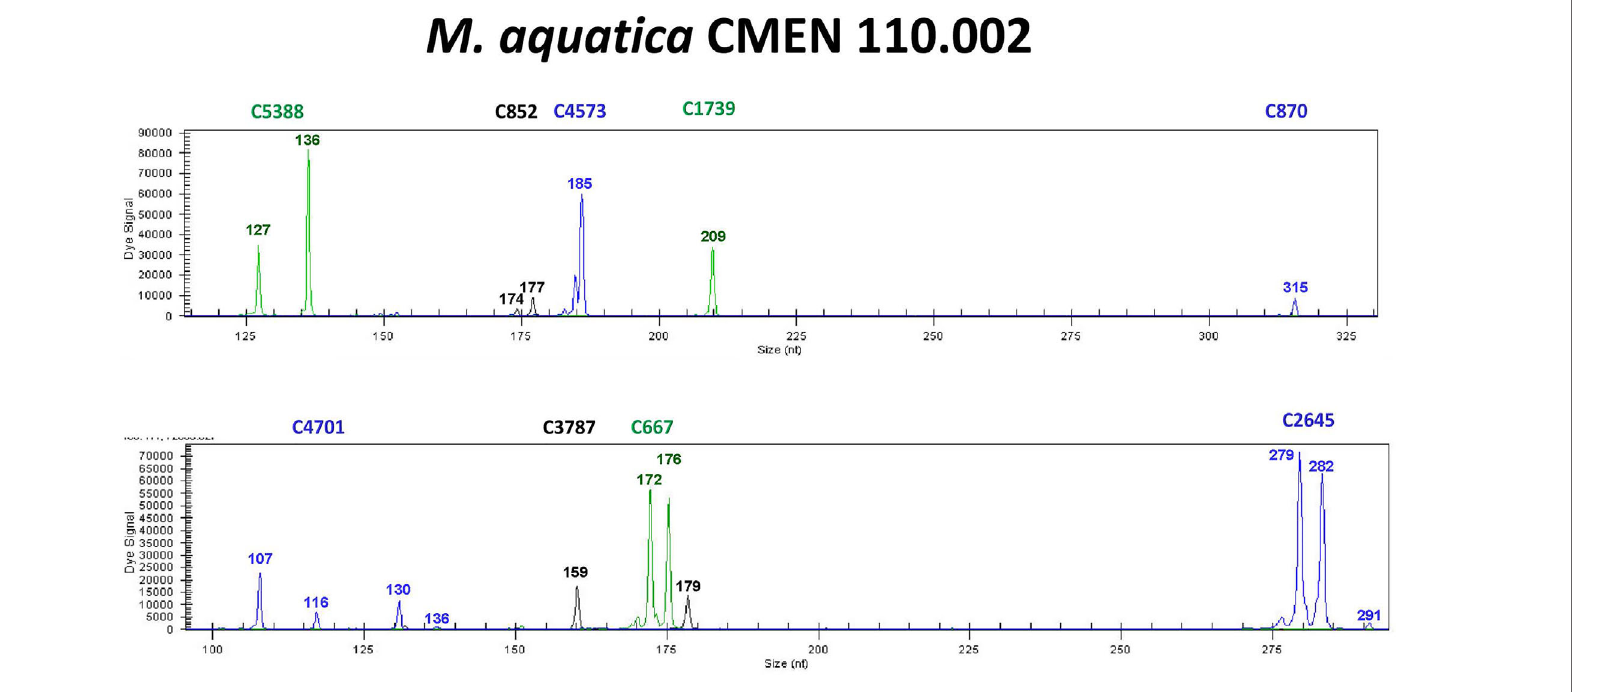
FIGURE 7 | Example of SSR genotyping with M. aquatica